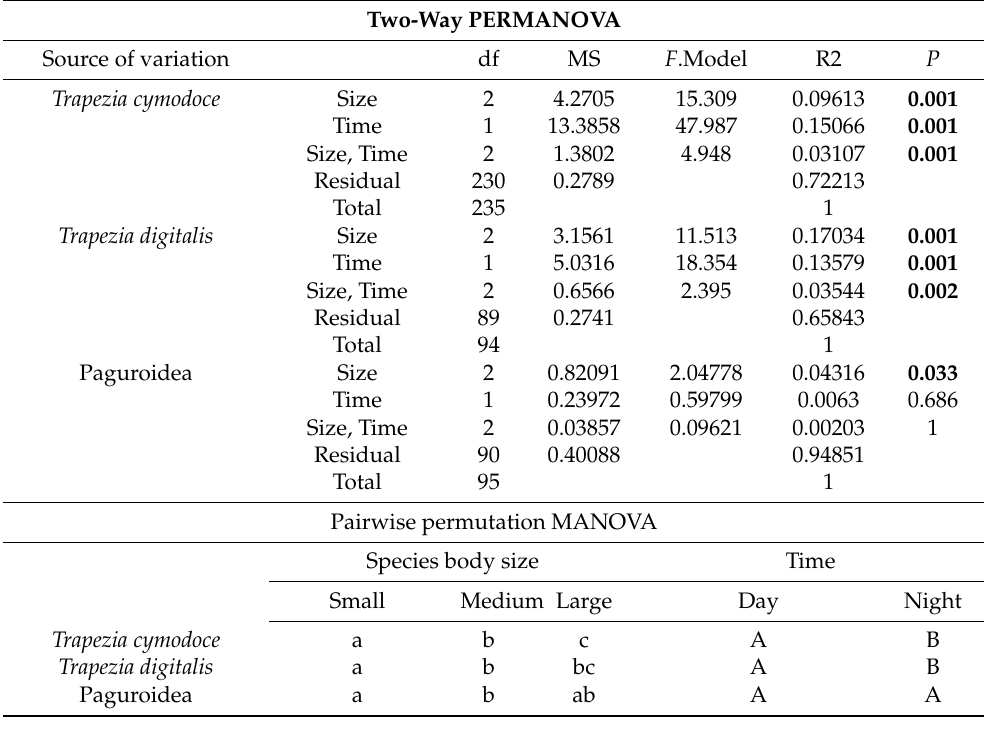
Table 3. Summary of two-way PERMANOVA testing for the effect of canopy dwelling species body size (small, medium, and large), daily time (day, night), and their canopy compartments occupation. Analyses were performed separately for each species based on Bray–Curtis dissimilarity and a 1.7 power transformation matrix of compartments distribution. Significant values are presented in bold ( p < 0.05). Two-Way